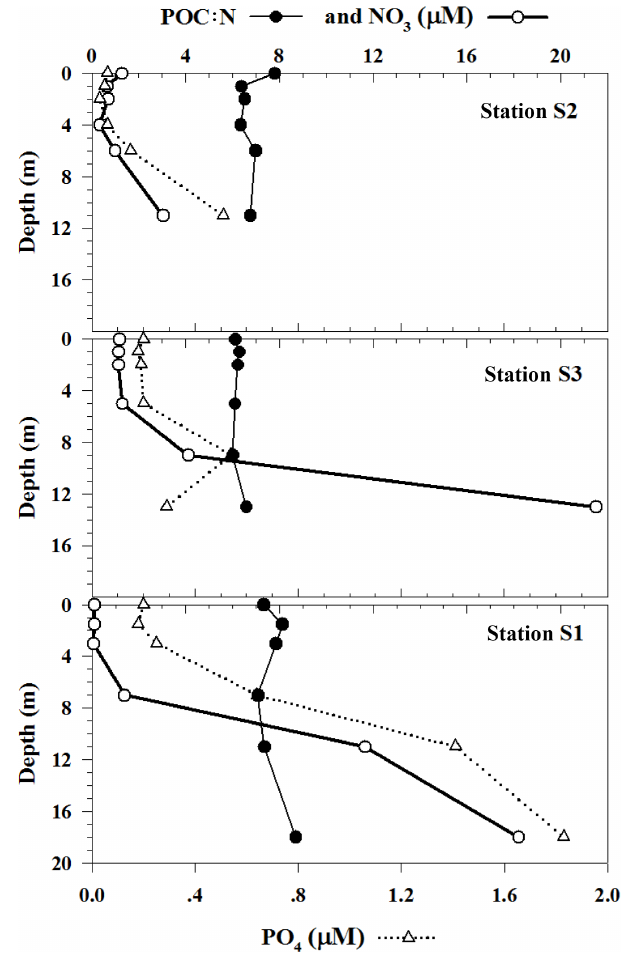
Figure 10. Vertical profiles of particulate organic C:N ratios at Sta- tions S2, S3 and S1 along the increasing distance from the river during 20–23 August